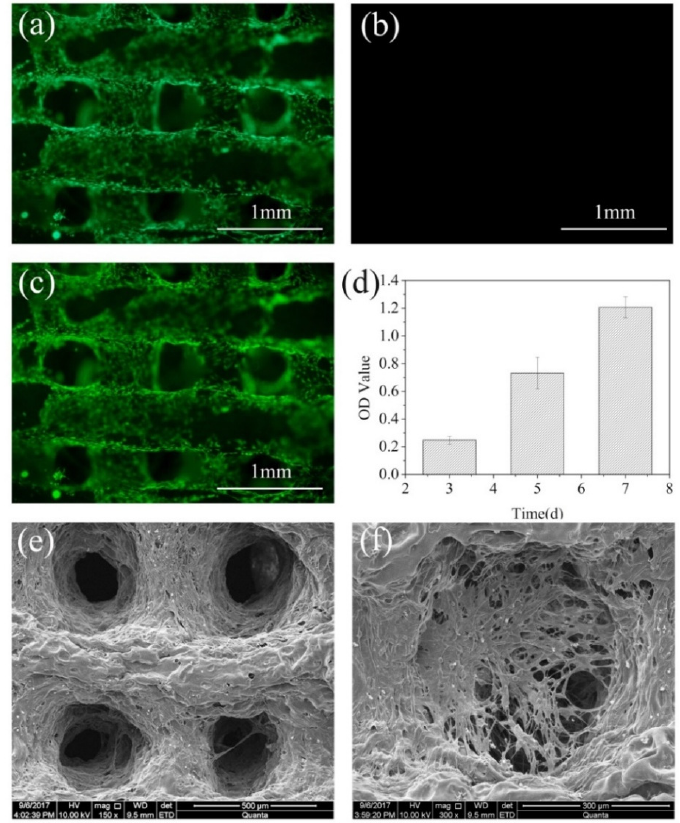
Figure 8. Biocompatibility of 3D printed AlCh PIC hydrogels. Inverted fluorescence microscope of ( a ) live; ( b ) dead; ( c ) merged cells at the 3rd day. ( d ) Proliferation of hASCs cultured on 3D printed AlCh PIC hydrogels. ( e , f ) SEM micrographs of 3D printed AlCh PIC hydrogels after cultured with hASCs for 3 days.